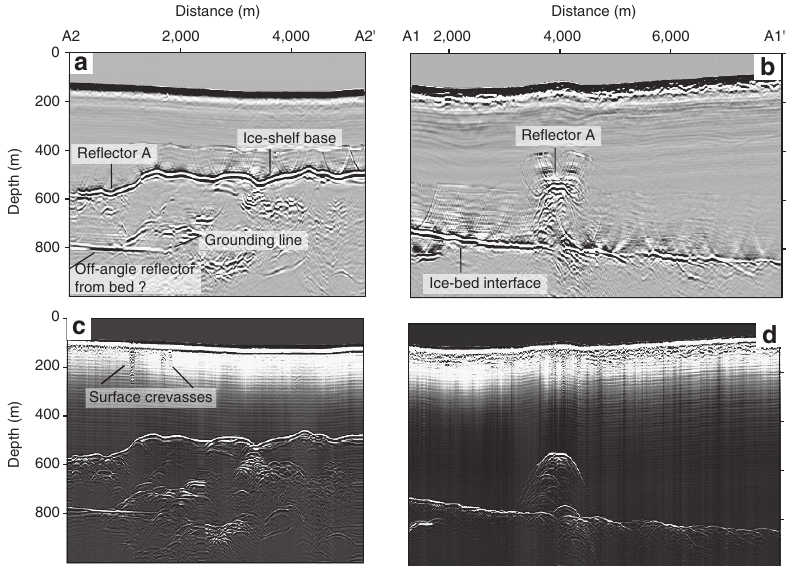
Figure 5 | Plain view of ice-shelf channel formation. 2D representation of the radar profiles A1–A1 0 and A2–A2 0 with ( a , b ) and without ( c , d ) migration. Depth conversion for ( c , d ) uses standard normal-moveout correction 58 . The migrated along-flow section ( a ) shows the location of the grounding line, and the transition from the top of reflector A into the base of the floating ice shelf. Reflections from near-surface crevasses seen in ( c ) are potentially caused by tidal bending. In the across-flow section ( d ), the reflection hyperbolas of reflector A collapse during the migration ( b ) showing that lateral walls are too steep to be imaged by our nadir-looking